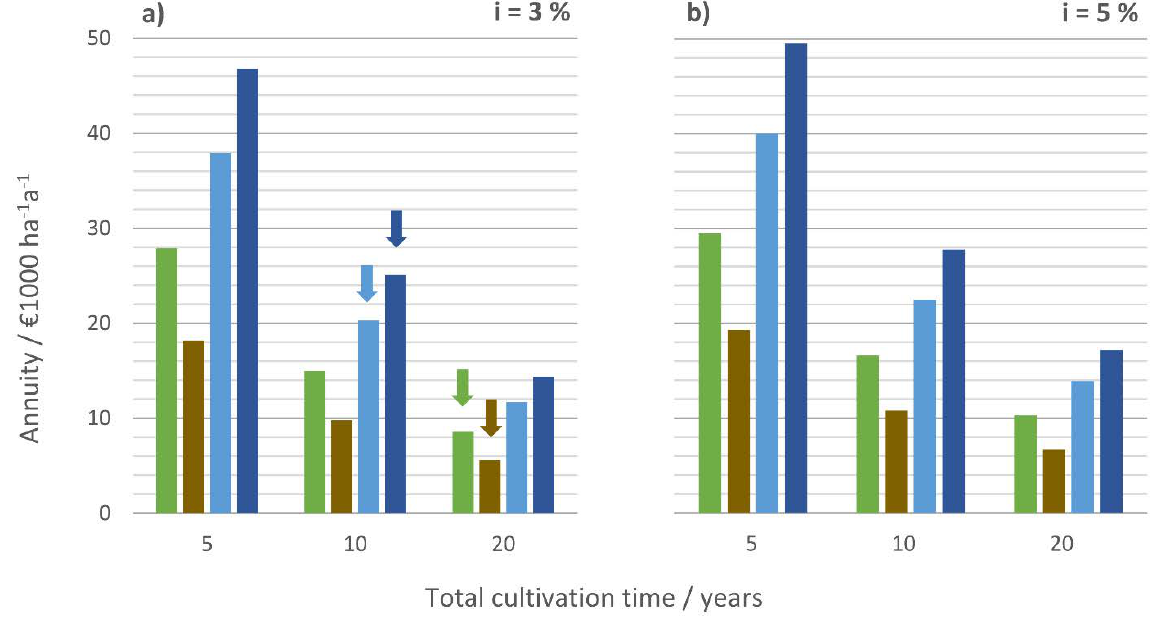
Figure 7. Annuities of initial establishment costs, calculated for an interest rate of a) 3 % and b) 5 %, for Sphagnum farming on former bog grassland (green), cut-over bog (brown) and floating mats without (light blue) and with (dark blue) pre-cultivation, and for assumed total cultivation times of 5, 10 and 20 years. The arrows indicate reasonable cultivation times for the different site types that have been used for further